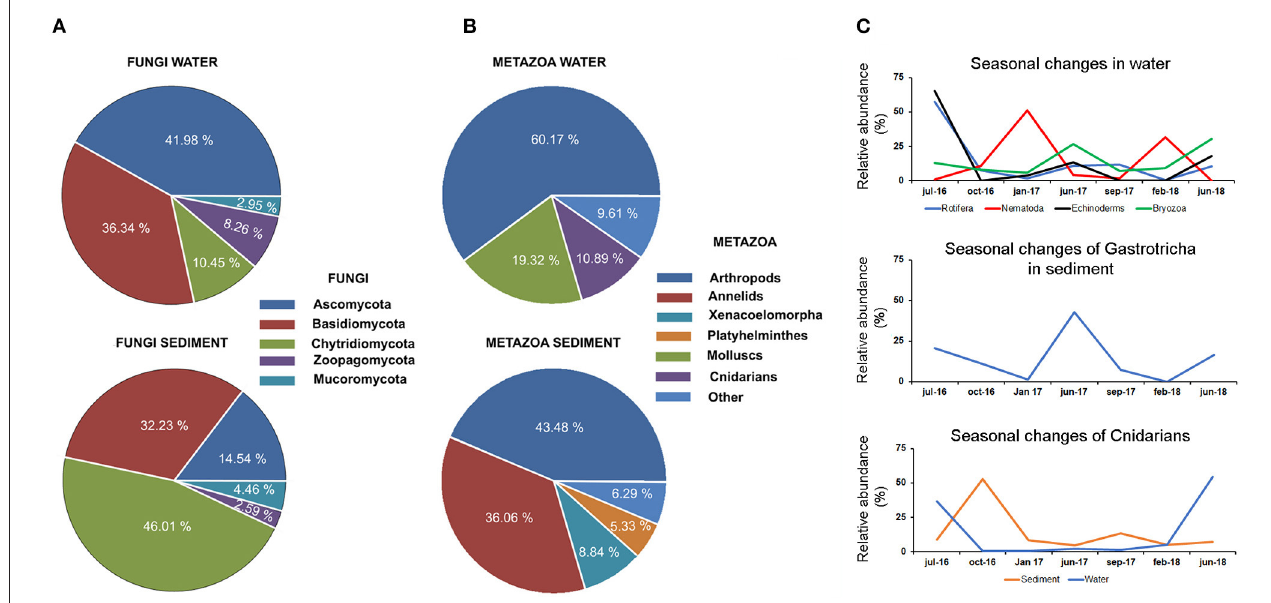
FIGURE 4 | Distribution of fungi (A) and metazoan (B) in the water and sediment. (C) Temporal data allowed us to describe seasonal changes in the abundance of several taxonomic groups in water and sediment. Seasonal changes were also described for cnidarians in water and sediment.